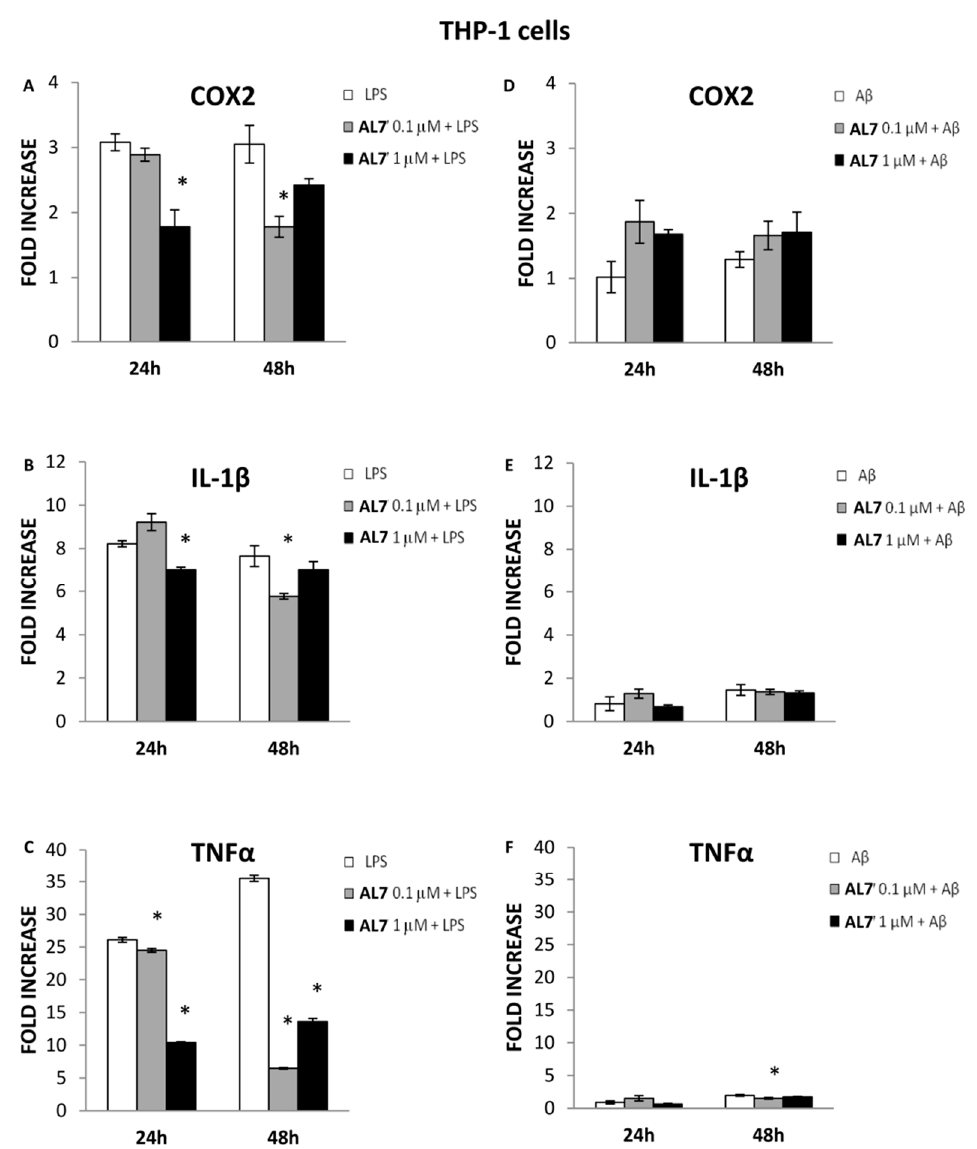
Figure 3. Effect of AL7 (0.1 and 1 μ M) on the expression of COX-2, IL-1 β and TNF- α in LPS- and A β -stimulated THP-1 cells (( A – C ), ( D – F ), respectively). The means ± SEM derived from three different experiments (each with n = 16; * p < 0.05, not significative p > 0.05).